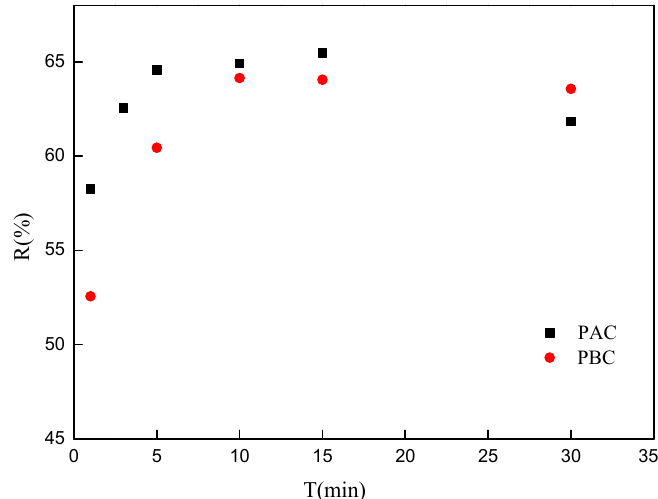
Figure 4. Adsorption kinetic of Sr by adaxial (PAC) and abaxial (PBC) cuticle of Photinia serrulata Leaf.